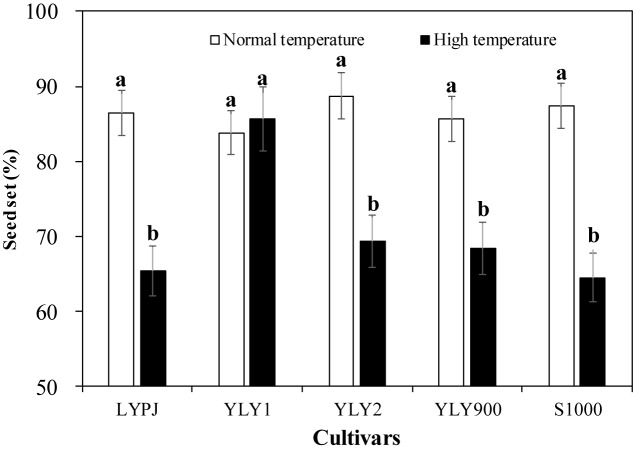
Heat tolerance of tested cultivars under growth chamber conditions. Different lowercase letters indicate significant differences at P < 0.05 between the control (normal temperature) and heat treatment (high temperature).